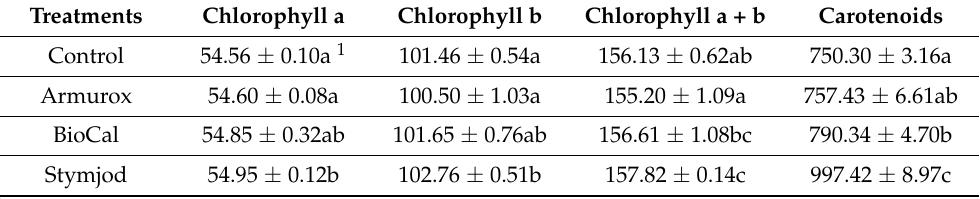
Table 2. Content of chloroplast pigments in highbush blueberry leaves (mg kg − 1 f.m.) in 2020.